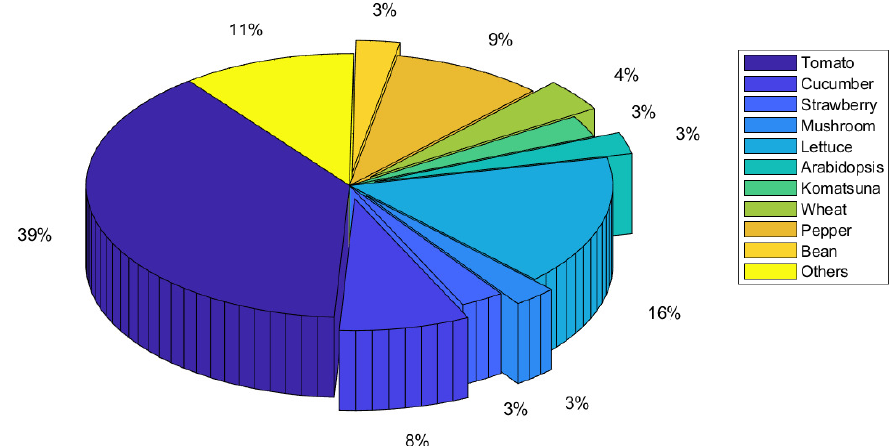
Figure 12. Growing medium distribution in controlled environment agriculture.